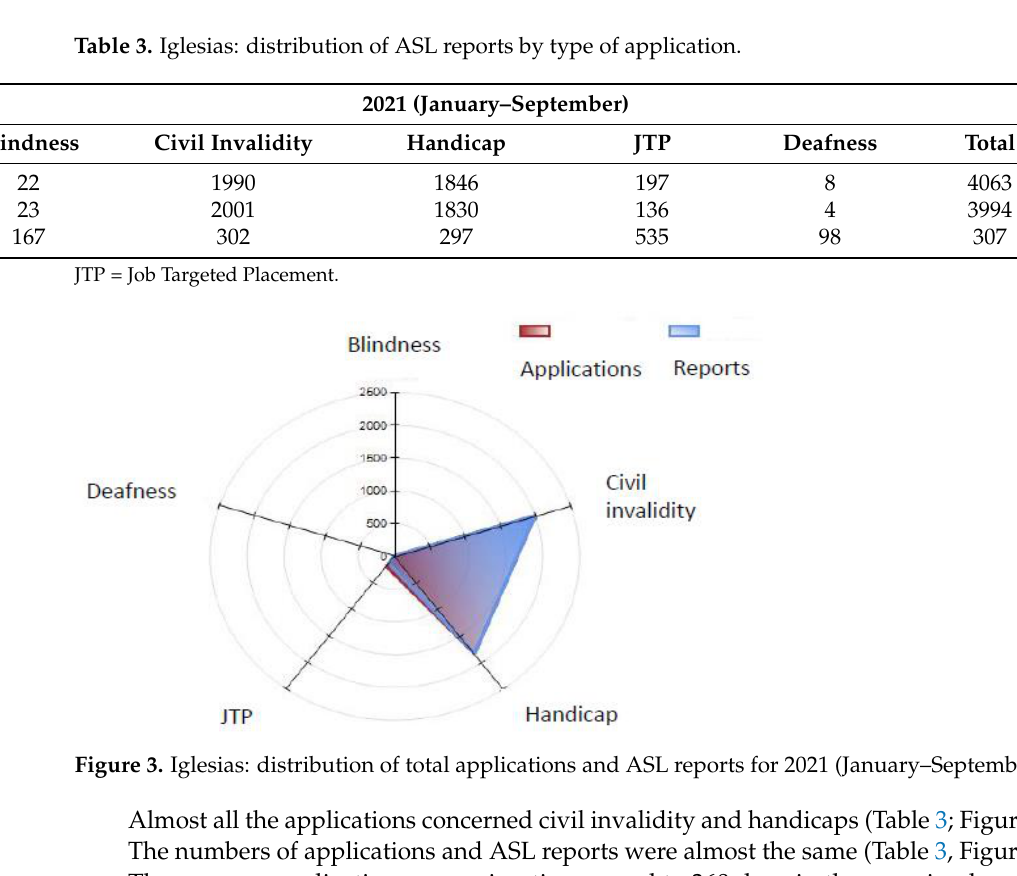
Figure 4 – Iglesias: trend of total applications and ASL reports 2021 (January-September)